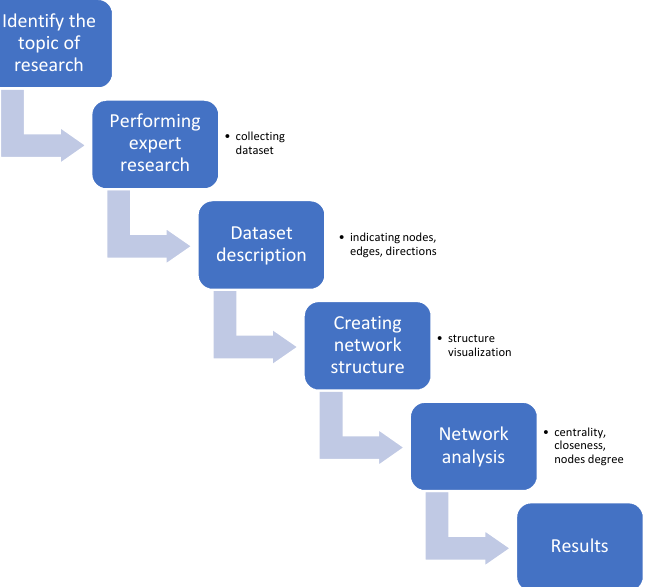
Figure 2. Structure of the research methodology using the SNA method.